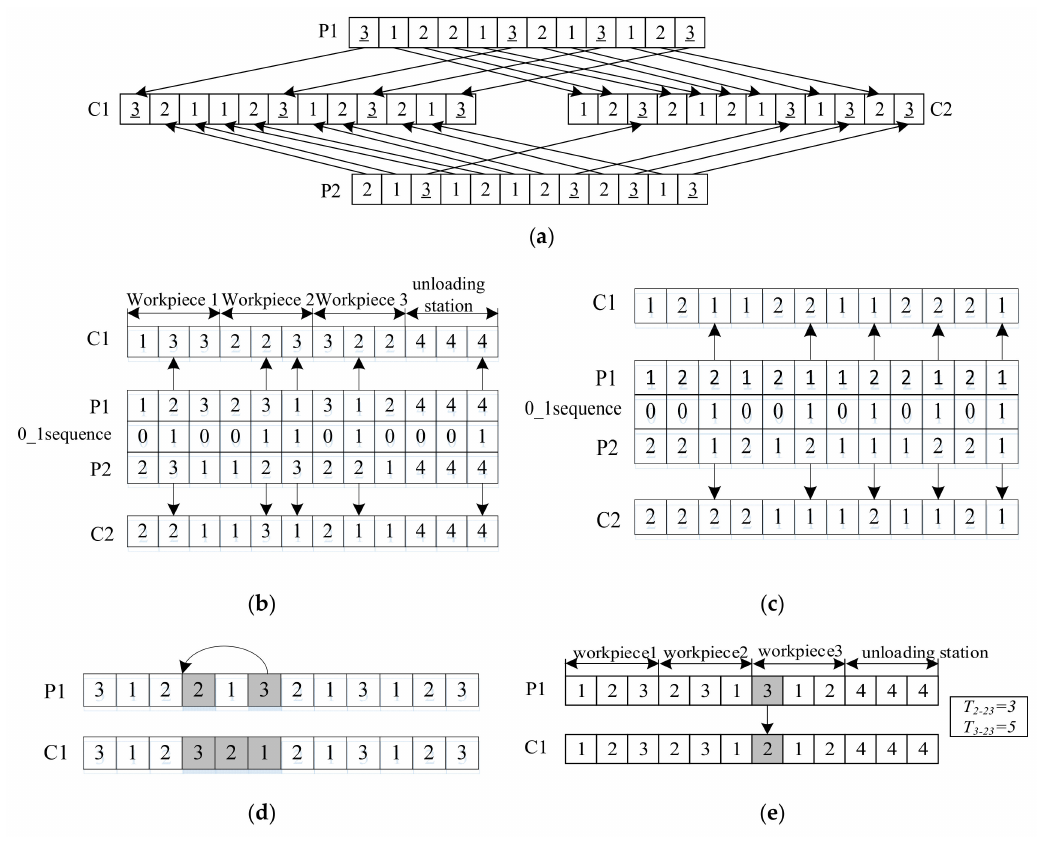
Figure 2. Chromosome crossover operation and mutation operation. ( a ) POX crossover operation of process code; ( b ) MPX interleaving operation of machine code; ( c ) MPX crossover operation of AGV code; ( d ) Mutation operation of process code; ( e ) Mutation operation of machine